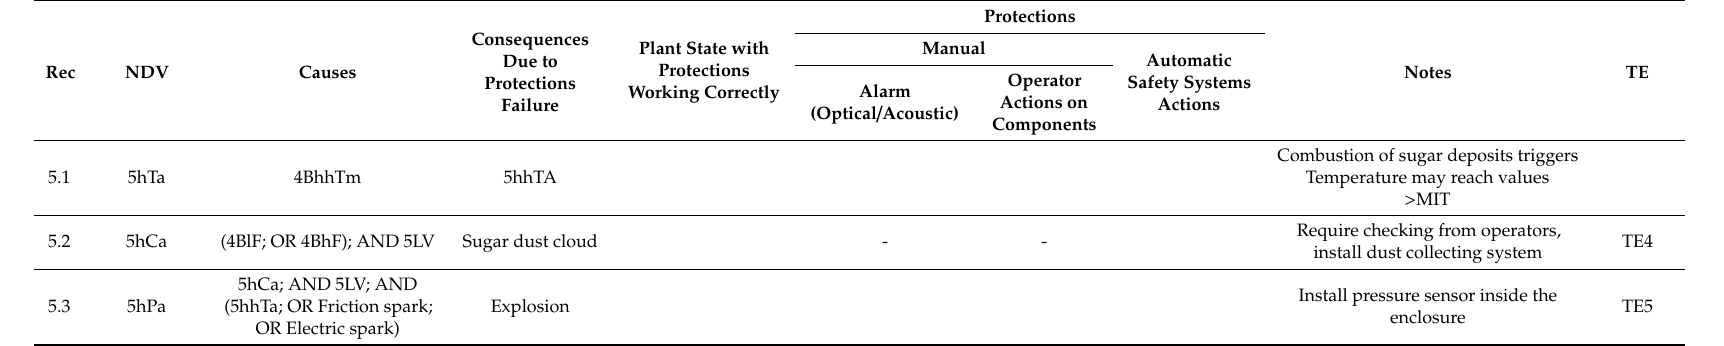
Table A2. ROA for the enclosure (Node